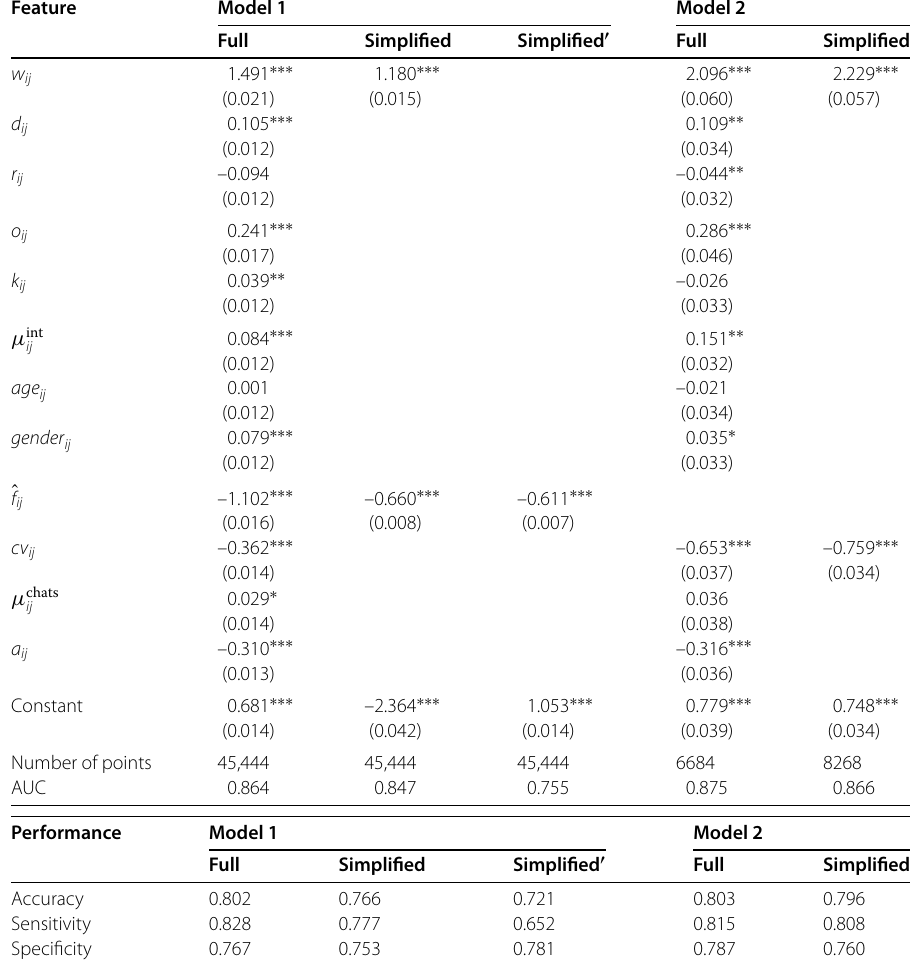
Table 2 Regression results for the tie persistence using generalized linear models for the two prediction